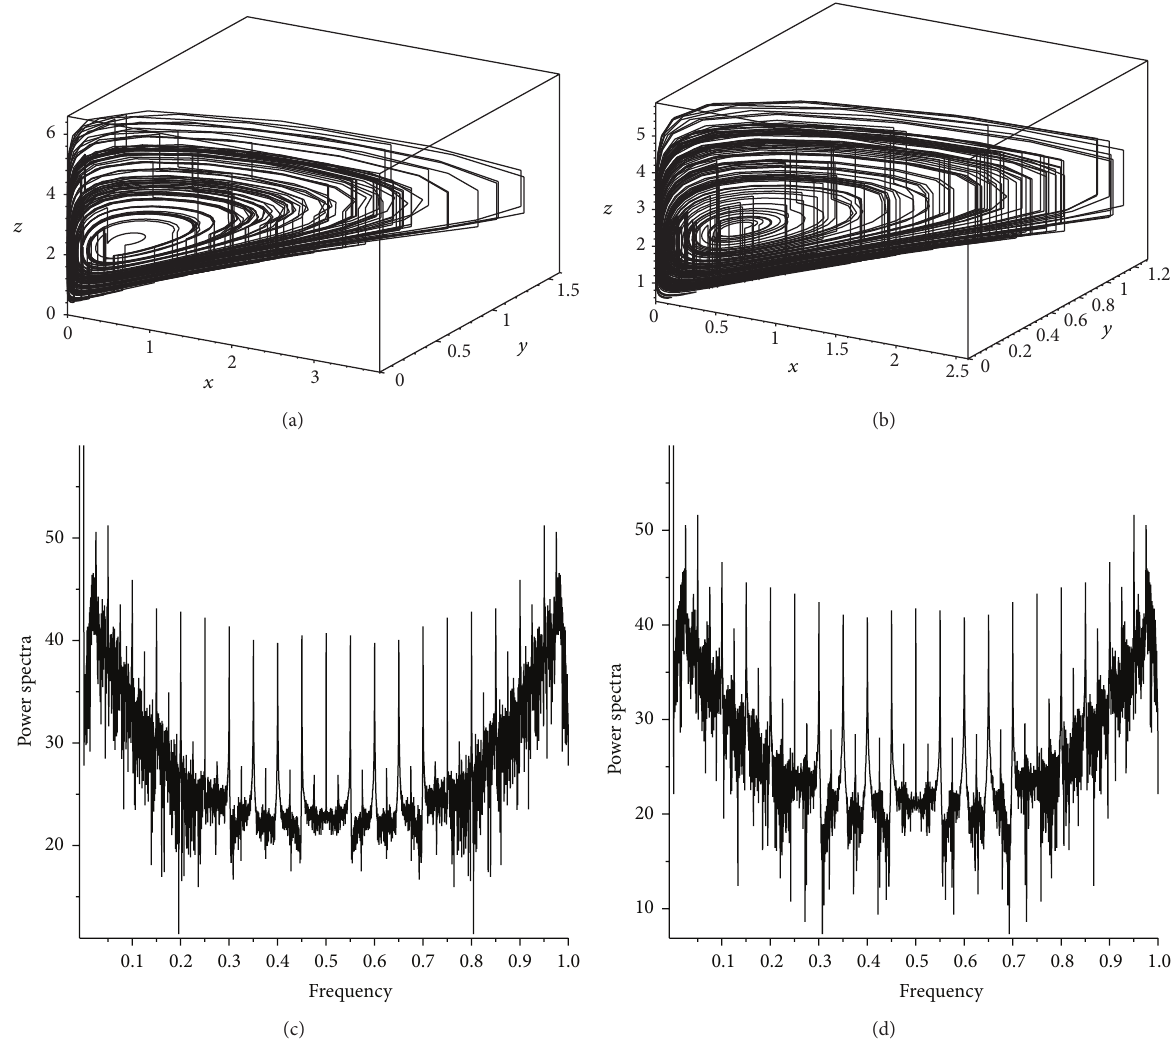
Figure 6: Strange attractors and power spectra: (a)strange attractor when 𝑝 = 1.2 , (b) strange attractor when 𝑝 = 1.51 , (c) power spectrum of attractor (a), and (d) power spectrum of attractor